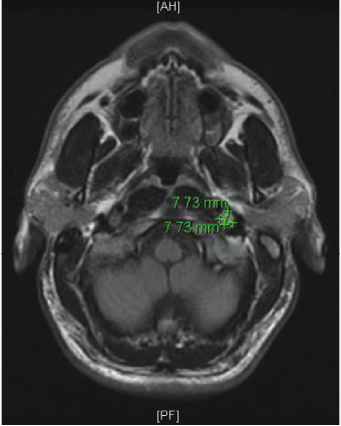
Figure 2: Axial Flair brain MRI demonstrating a mass in the left posterior carotid space at the skull